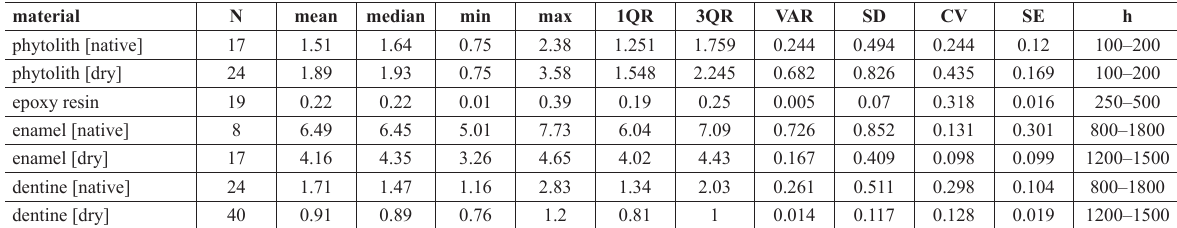
(GPa) given for the materials analysed (phytoliths = Table 1. Descriptive statistics of the nano-indentation hardness values H IT Phragmites australis , enamel and dentine = wild boar ( Sus scrofa ), N indents = number of indents measured, min = minimum val- ue, max = maximum value, 1Q = first quartile, 3QR = third quartile, VAR = variance, SD =standard deviation, CV = coefficient of variation, SE = standard error, h = indentation depth [nm]).